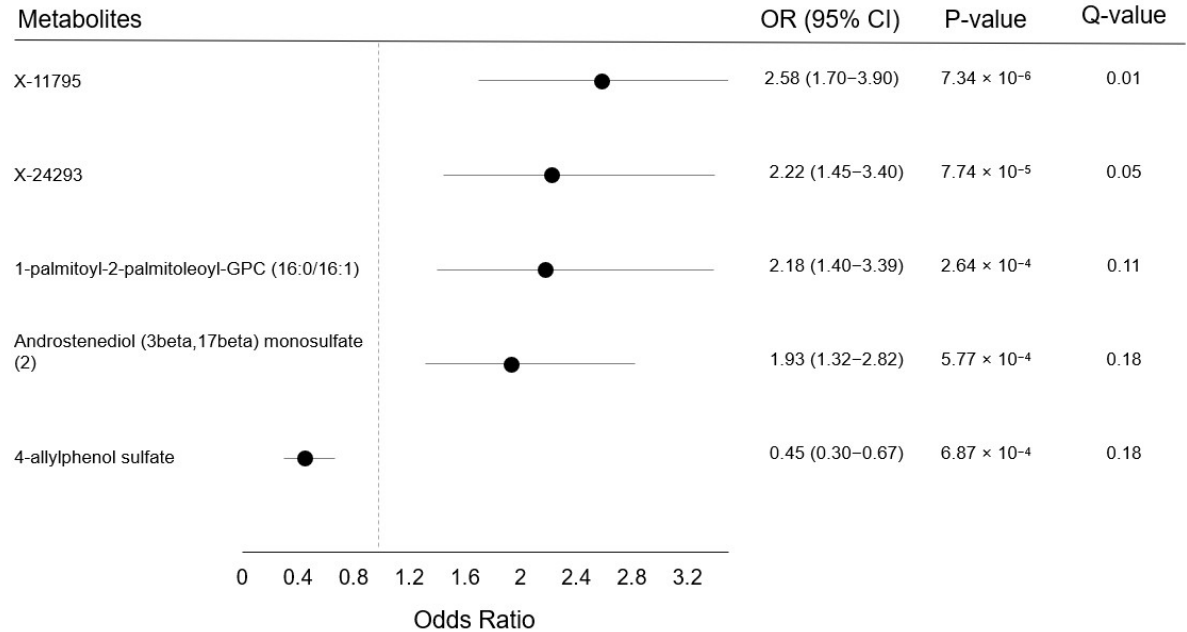
Figure 3. Odds ratios, 95% confidence intervals, p -values, and Q -values among non-hormone users at baseline for post- menopausal breast cancer when comparing the 90th with the 10th percentile levels of metabolites (n = 319 cases). Results were from unconditional logistic models adjusted for age at blood draw and are presented only for metabolites below the false discovery rate threshold of 0.20. Markers indicate the odds ratio, and error bars, the 95% confidence intervals. The Q -value is the estimated probability of a false discovery.